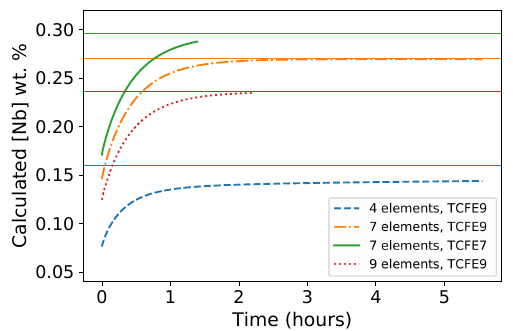
Figure 5. Average Nb content in austenite due to Nb(C,N) evolution as a function of holding time at 1473 K calculated using DICTRA software with the MOBFE4 kinetic database and the TCFE7 and TCFE9 thermodynamic databases for different numbers of elements taken into account. The starting point (0 min) corresponds to equilibrium at 1373 K; the horizontal solid lines give the Nb content in austenite at equilibrium at 1473 K, according to Table